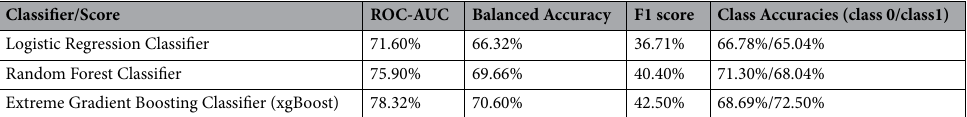
Table 3. Evaluation metric scores for different classifiers; Logistic Regression, Random Forest Classifier, xgBoost Classifier trained in all study phases dataset. Evaluation metrics include ROC AUC (Receiving operating characteristic Area Under the Curve), balanced accuracy, F1 score for class 0 and class specific accuracies (class 0/ class 1).